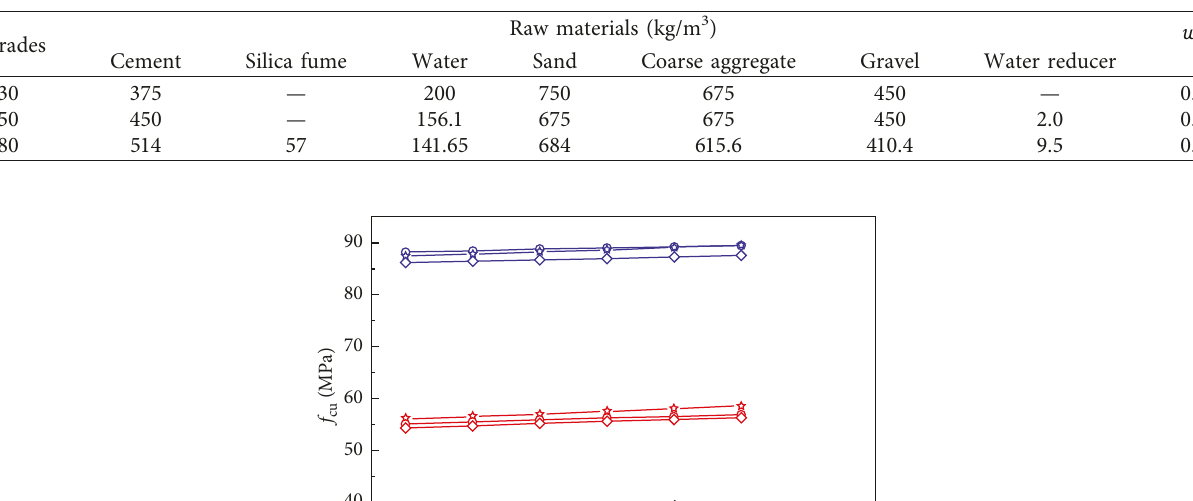
Table 7: Mix design of raw materials.